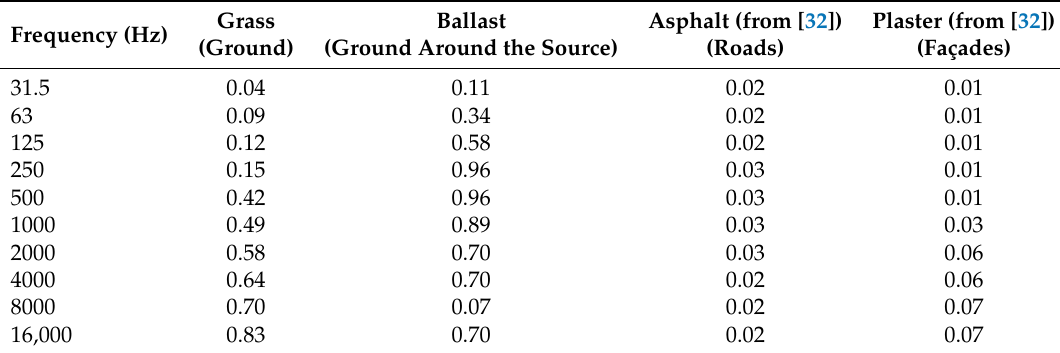
Table 1. Sound absorption coefficients for different model elements.